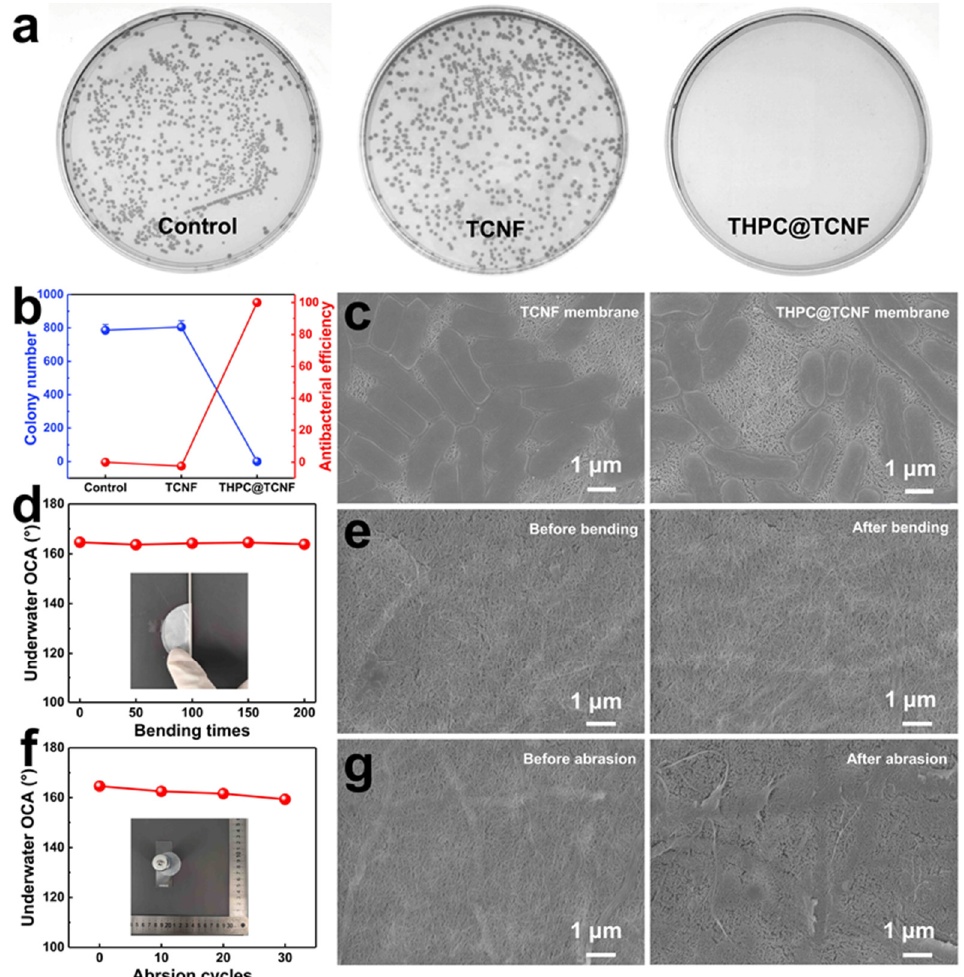
Figure 6. ( a ) Colony photographs after immersion test of control group, TCNF membrane and THPC@TCNF membrane against B. subtilis bacteria, respectively. ( b ) Corresponding statistics of the colony forming units and antibacterial efficiency. ( c ) SEM images of B. subtilis after contacting with TCNF membrane and THPC@TCNF membrane for 1 h. ( d ) Underwater OCA and ( e ) SEM image of